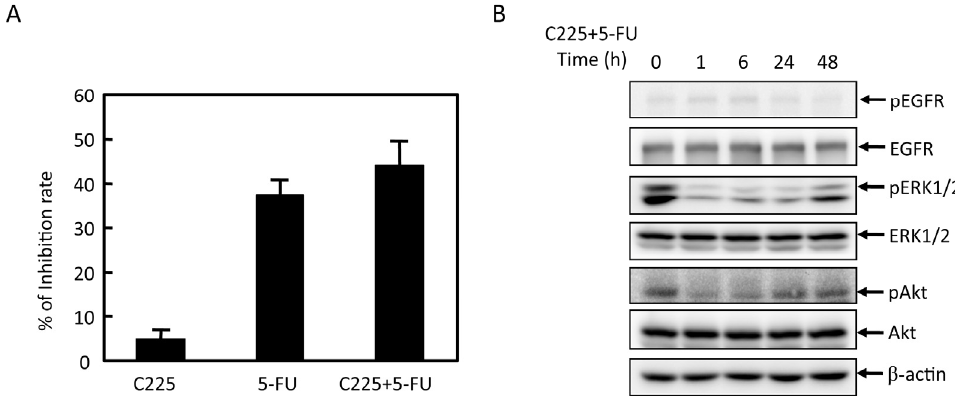
Figure 3. Effects of EGFR inhibitor (C225) on pERK, ERK, pAkt and Akt expression upon 5-FU treatmentin MGC803 cells. ( A) MGC803 cells were pretreated with 10 µg/mL C225, and then treated with 5-FU for the indicated time. Inhibition rate was tested by MTT assay. The percentage of untreated samples was 100%; and ( B ) pEGFR, EGFR, pERK, ERK, pAkt, and Akt expression was evaluated by western blot. Representative results from at least three individual experiments are